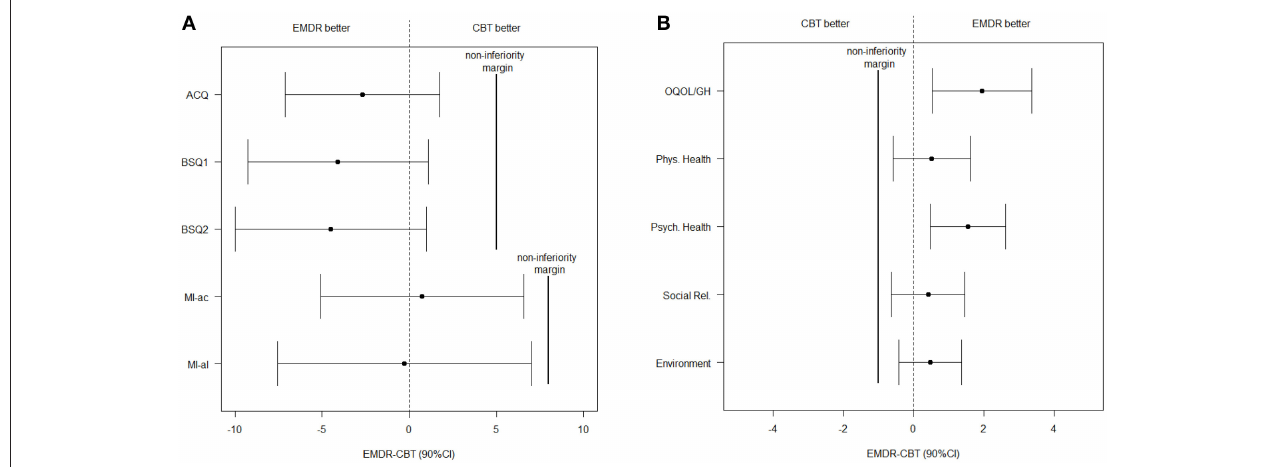
FIGURE 2 | Unadjusted effects and 90% CI of (A) the symptoms and (B) the quality of life facet and domains at T3. ACQ, Agoraphobic Cognitive Questionnaire; BSQ1, Body Symptoms Questionnaire (amount of fear); BSQ2, Body Symptoms Questionnaire (how often sensations are experienced); CBT, Cognitive Behavioral Therapy; CI, Confidence Interval; EMDR, Eye Movement Desensitization and Reprocessing; MI-ac, Mobility Inventory (when accompanied); MI-al, Mobility Inventory (when alone); QOL, Quality Of Life; OQOL/GH, Overall Quality Of Life and General